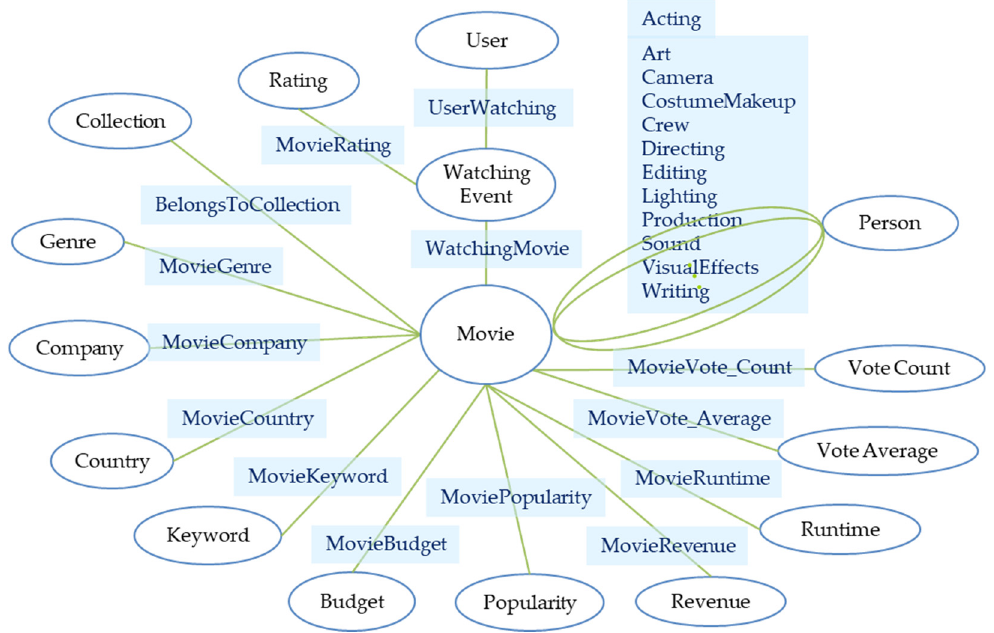
Figure 17. User rating ontology schema (movie domain).